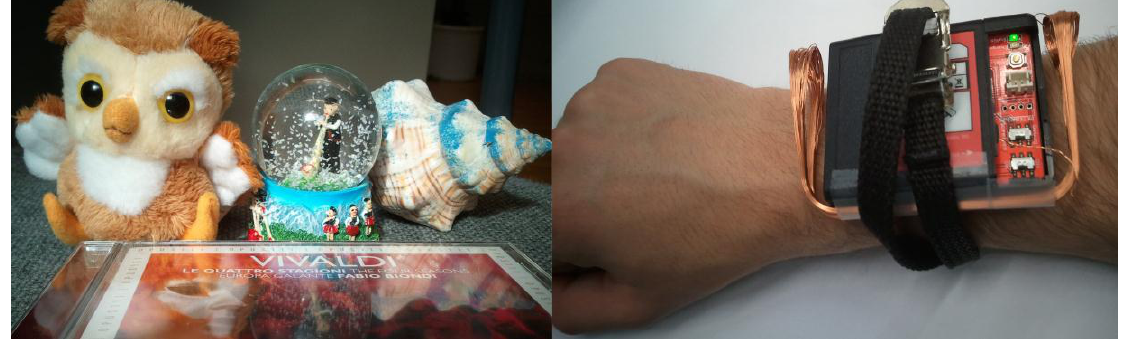
Figure 13. The 4 objects of the user evaluation ( left ), the fake prototype ( right